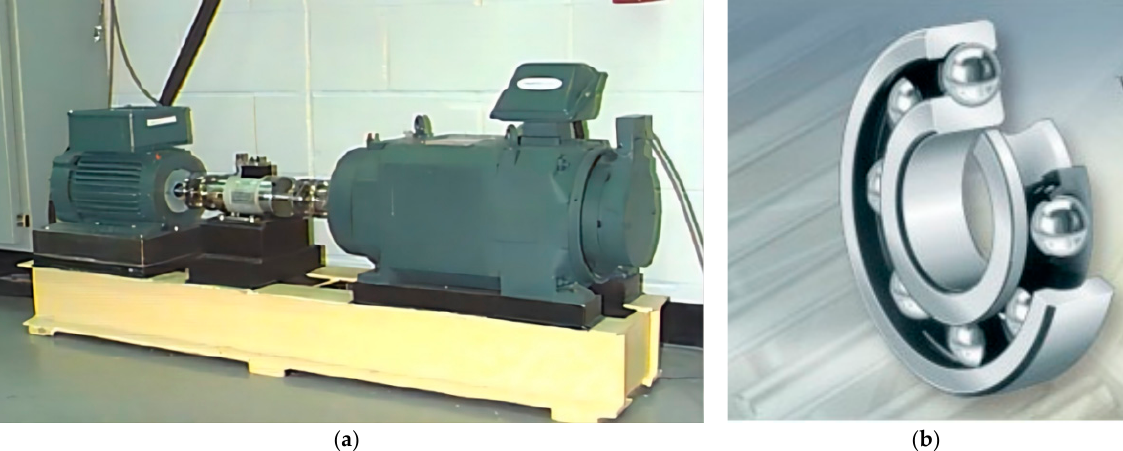
( d ) Figure 13. Performance evaluation of other state-of-art methods. ( a ) The components obtained by LMD. ( b ) The components obtained by ITD. ( c ) The components obtained by CEEMDAN. ( d ) The components obtained by SVMD. 4.2. Analysis of Test Data In order to further verify the effectiveness of the proposed method in actual signal analysis, in this paper, the bearing fault signal of Western Reserve University was ap- plied as the verification data [42]. As shown in Figure 14, the bearing fault test rig mainly consists of an induction motor (2 HP), a torque transducer, a dynamometer, and several